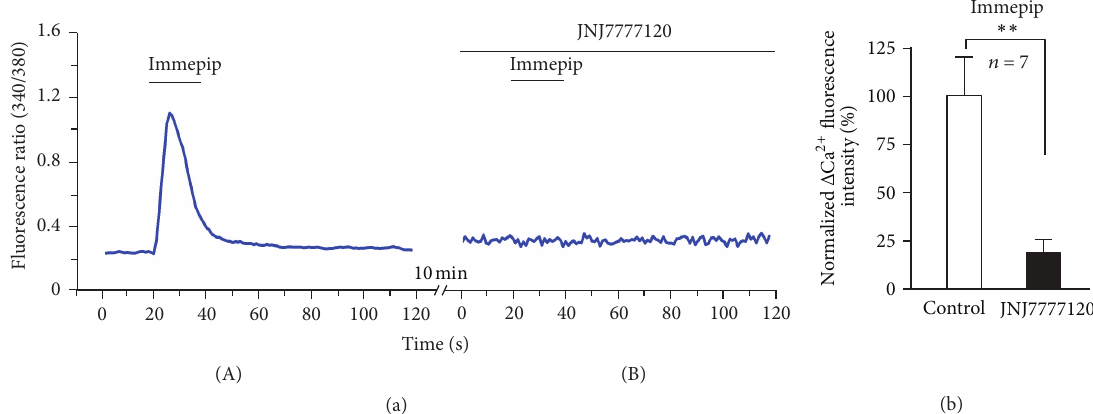
Figure2:ImmepipisaselectiveagonistofH4receptorontheDRGneurons.(a)H4antagonistJNJ7777120(1 𝜇 M)totallyblockedtheimmepip (50 𝜇 M)-induced increase in [ Ca 2+ ] i ( 𝑁 = 7 ). (b) Normalized Δ Ca 2+ fluorescence intensity (%) of the responsive neurons. ∗∗ 𝑃 < 0.05 .